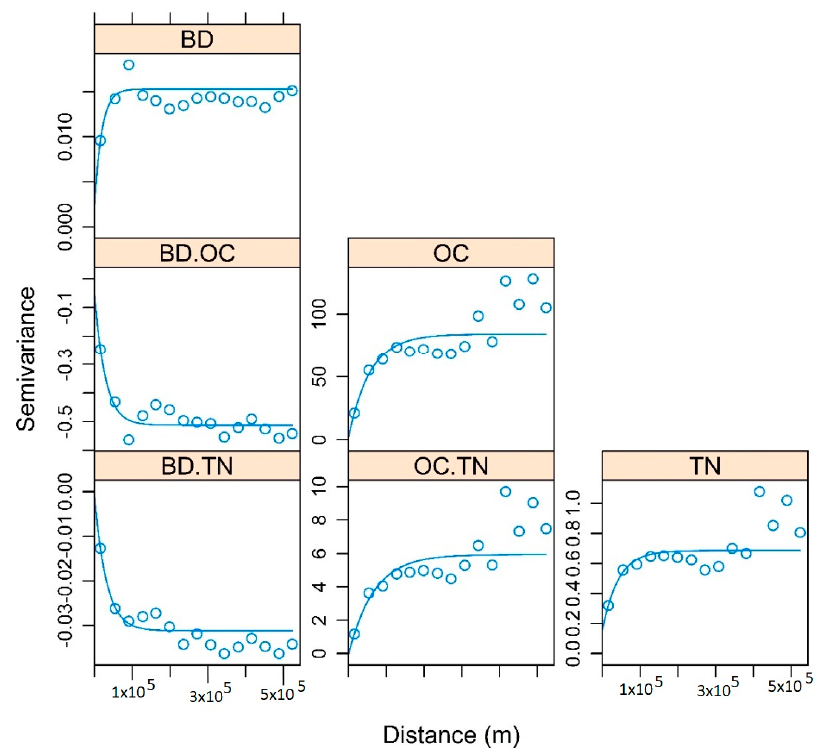
Figure 2. Scatter matrix plots of soil health indicators showing the scatterplot matrix, with histograms, kernel density overlays, correlation, and significance levels ( *** p < 0.001).